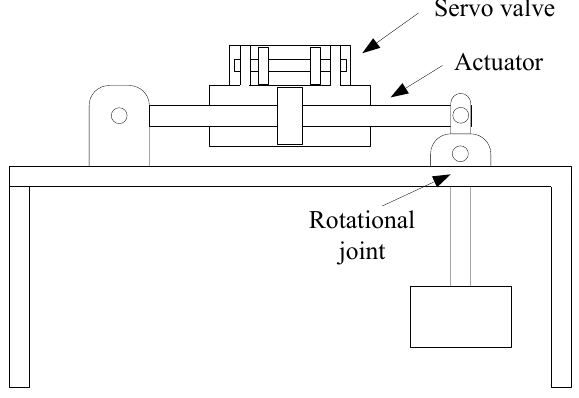
Figure 1. EHA with a rotational